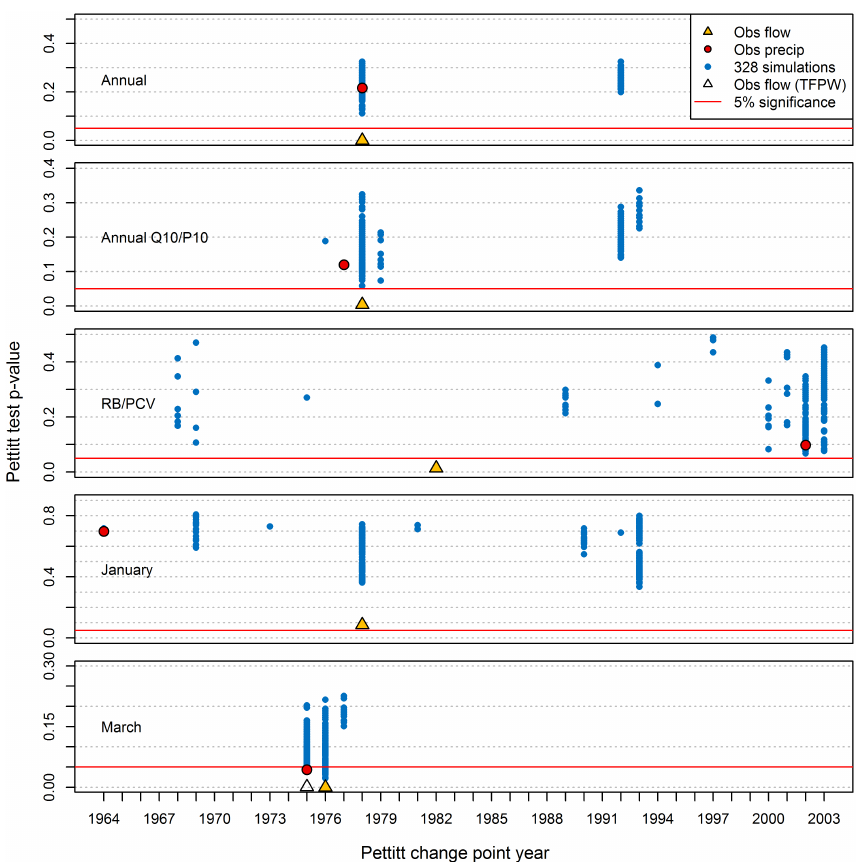
Figure 9. Pettitt test for change points in selected indicators. Solid red lines represent the threshold for significant change points at the 5% level, with p values below (above) indicating a significant (non-significant) change point for corresponding year of change on the x axis.